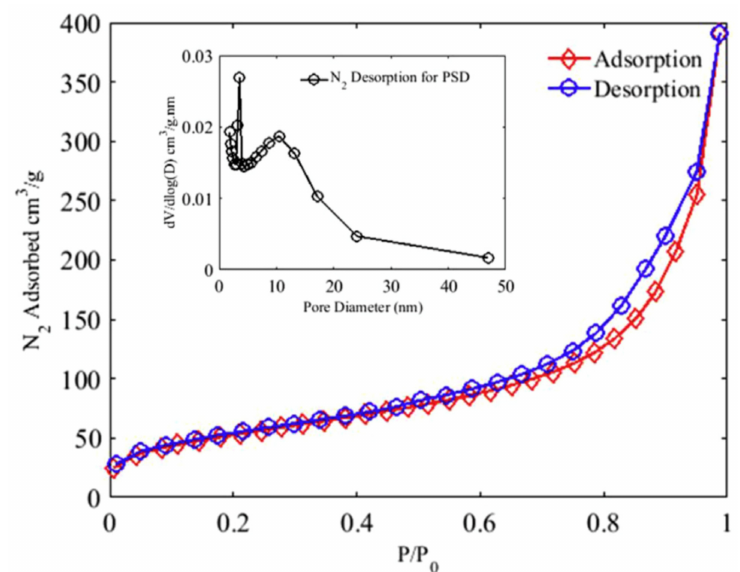
Figure 9. N 2 adsorption-desorption isotherms of bio-MOF-11-Co used to calculate surface area and pore size distribution (PSD) using the Barrett-Joyner-Halenda method [68] . Reprinted from